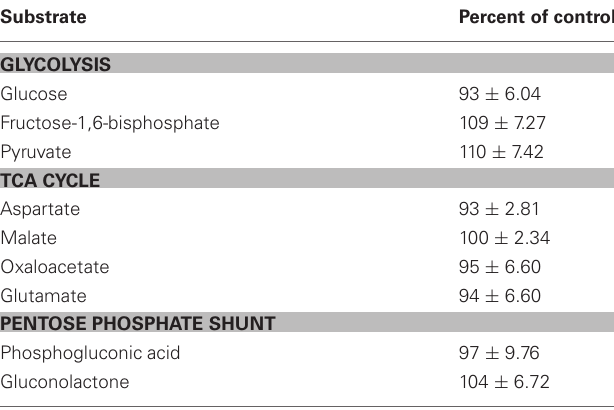
Table 1 | After 60min of incubation, intermediates in glycolysis, the TCA cycle, and the pentose phosphate shunt did not affect the accumulation of 45 Ca 2 + .